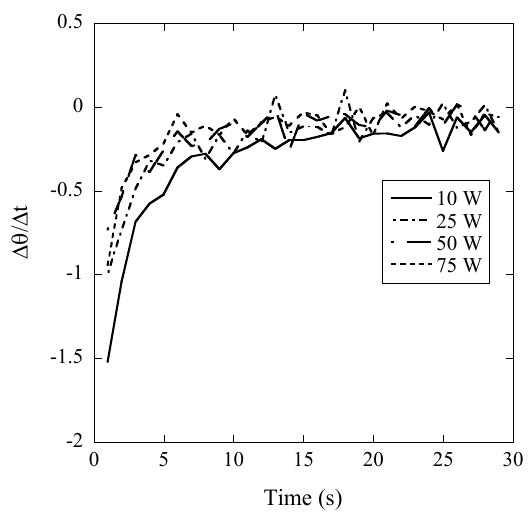
Figure 5. The first derivative of the curves of static water CA evolution during the 30-s period of